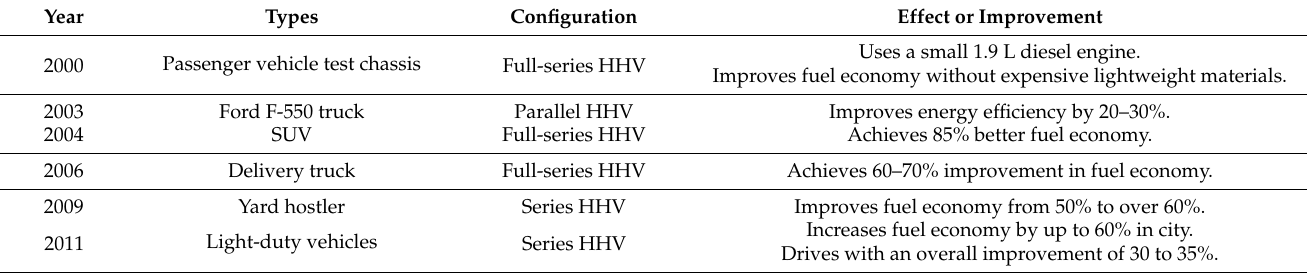
Table 3. Types, configurations and main features of hydraulic hybrid vehicles over time in